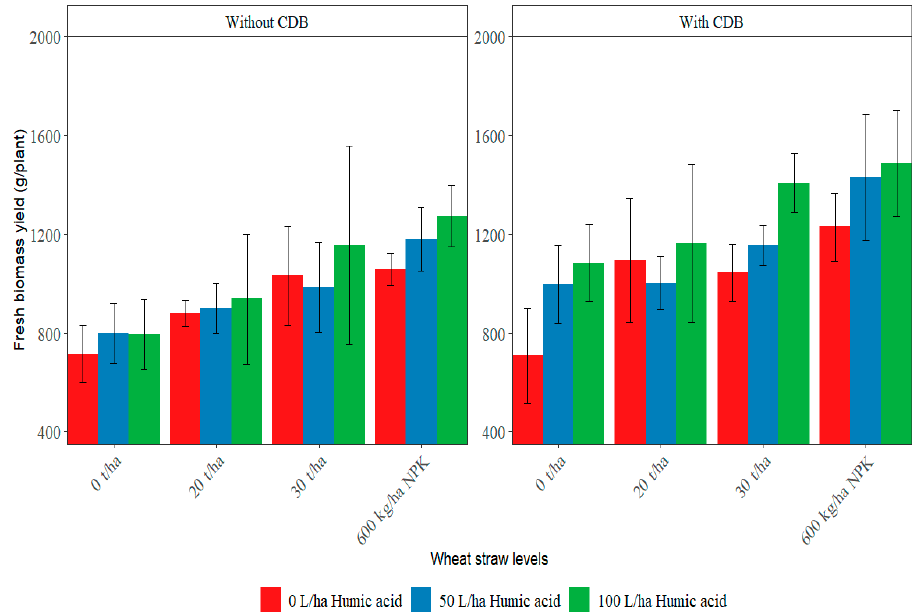
Figure 1. Interaction effects of humic acid levels with and without cellulose-decomposing bacterium on the leaf area of squash plant in 2021 planting season. Bars indicate ± standard error, and error bars that are not overlapping each other indicate that the means are significantly ( p ≤ 0.05) different from each other.